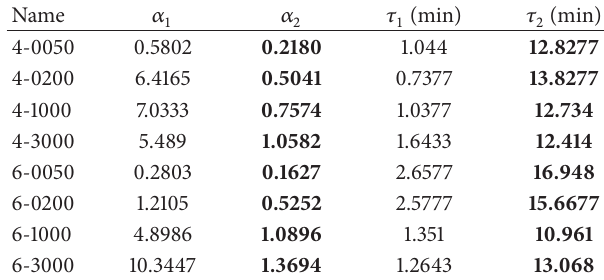
Table 4: Fitting parameters of the experimental decay curves conducted in this study, where the value 4 denotes 0.4 mm and the value 6 denotes 0.6 mm in thickness; the values 0050, 0200, 1000, and 3000 represent the luminous intensity of excitation. A double exponential equation was applied in